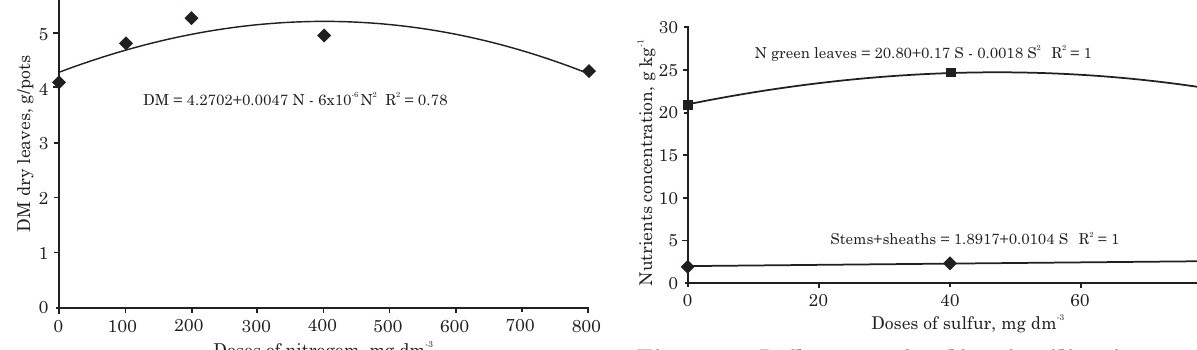
Figure 5. Influence of sulfur fertilization on N concentration in green leaves and sulfur in stems + sheaths of Brachiaria decumbens .